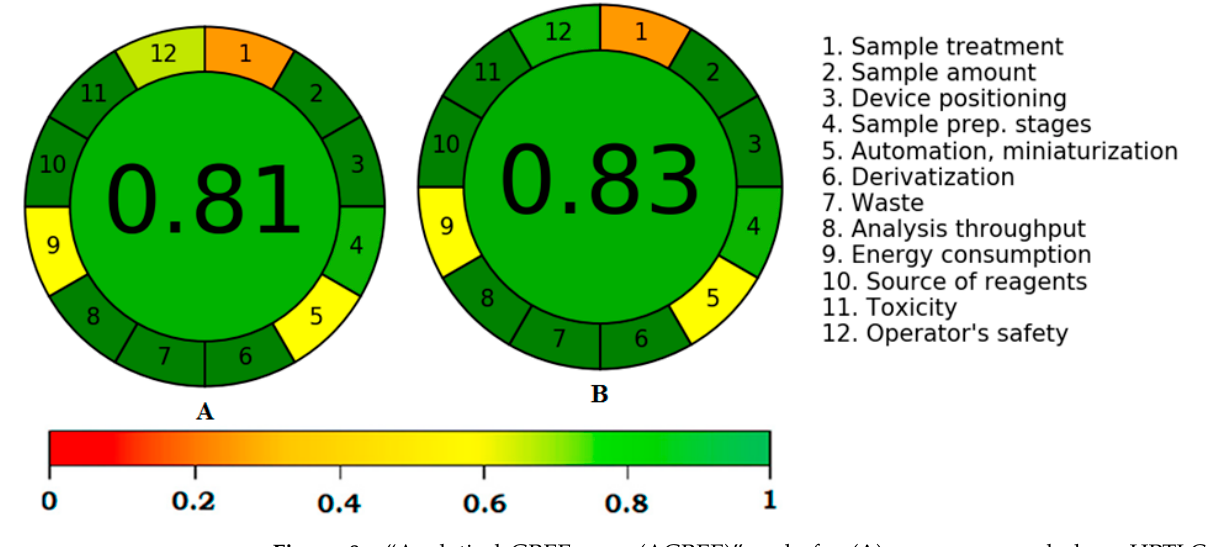
Figure 8. “Analytical GREEnness (AGREE)” scale for ( A ) greener normal ‐ phase HPTLC and ( B ) greener reversed ‐ phase HPTLC